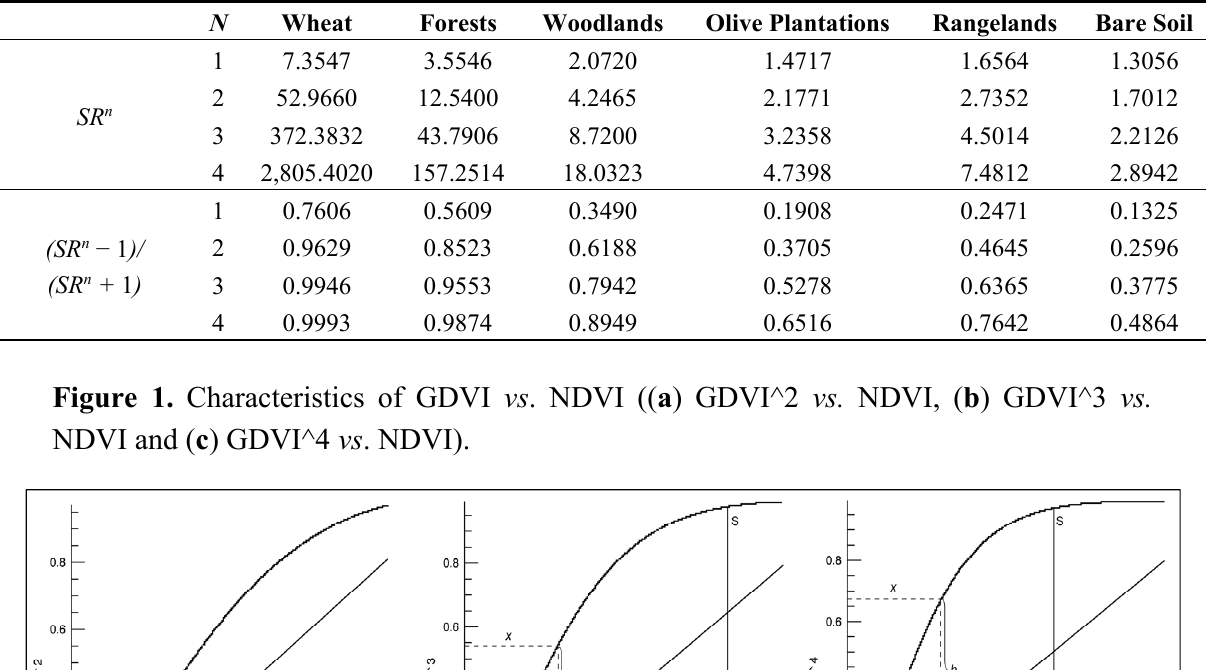
Table 2. Atmospherically corrected and reflectance-based Simple Ratio Index (SR) and its derivatives ( n > 1).